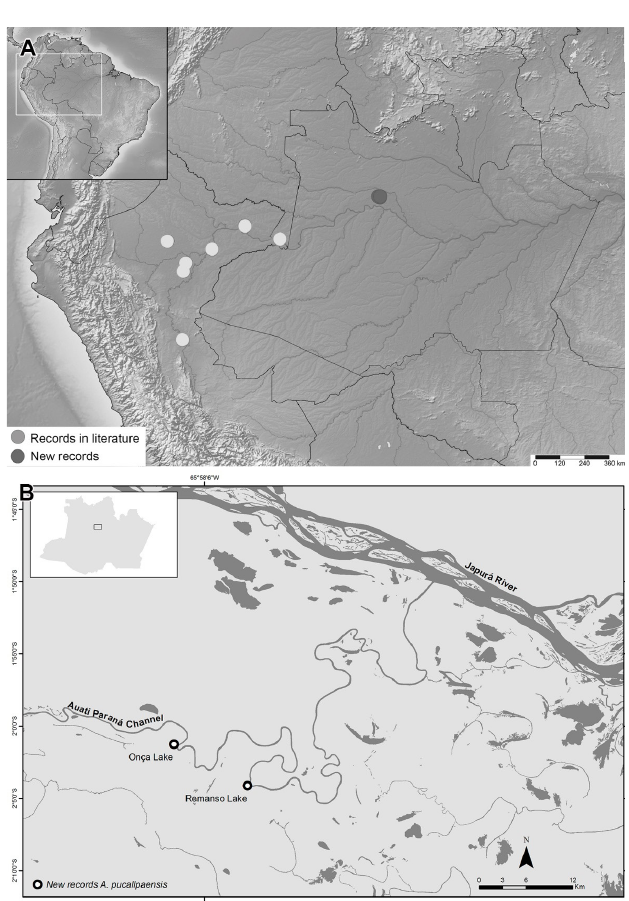
Figure 2. Geographical records of Apistogrammoides pucallpaensis . (A) Known geographical distribution; (B) Two new records in Amazonian lakes of